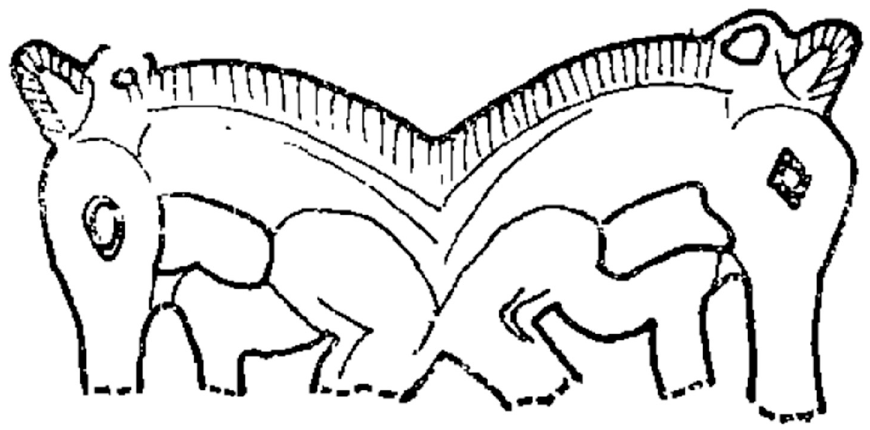
Figure 7. Plaque of double-horse, gold, excavated from Liujiazi, Horqin Left Middle Banner Banner, Inner Mongolia; after (Zhang 1989, p. 435).